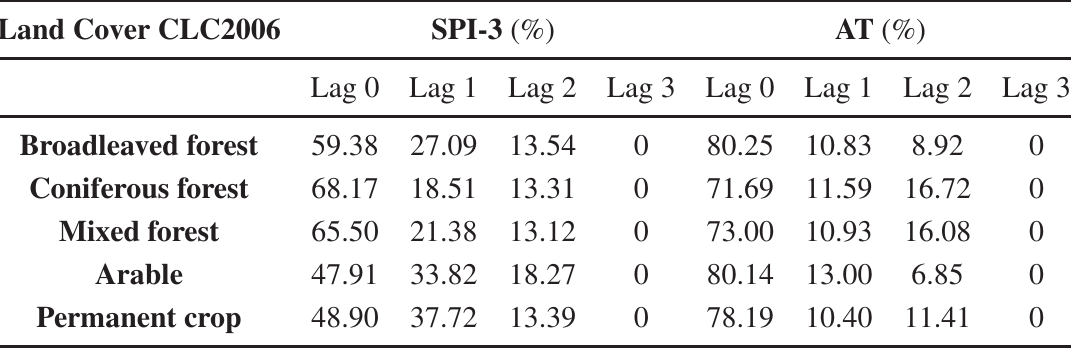
Table 2. Percentage of land cover classes where the cross-correlation between anomalies of FAPAR, SPI-3 and AT is significant at different